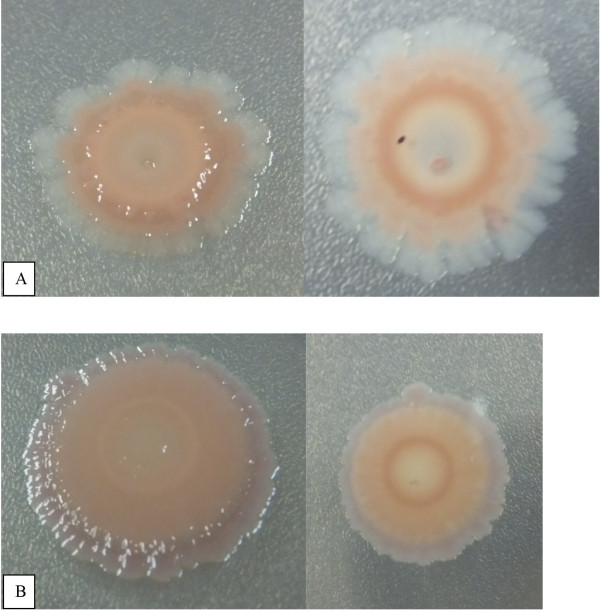
RDAR Morphotype in Salmonella Typhi. Morphotype of red, dry and rough (RDAR) colony which shows presence of curli and cellulose in S. Typhi and S. Typhimurium after 7 days of cultivation at 37°C on Congo Red Agar. Panel A: Morphotype of S. Typhi. Left panel and right panel are the front view and back view of S. Typhi RDAR colony morphotype on Congo Red Agar, respectively. Panel B: Morphotype of S. Typhimurium as a control. Left panel and right panel are the front view and back view of S. Typhimurium RDAR colony morphotype on Congo Red Agar, respectively.